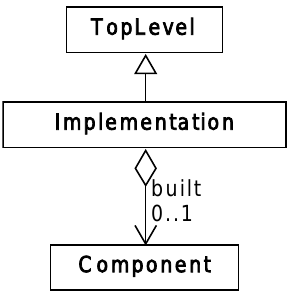
Figure 17: Diagram of the Implementation class and its associated